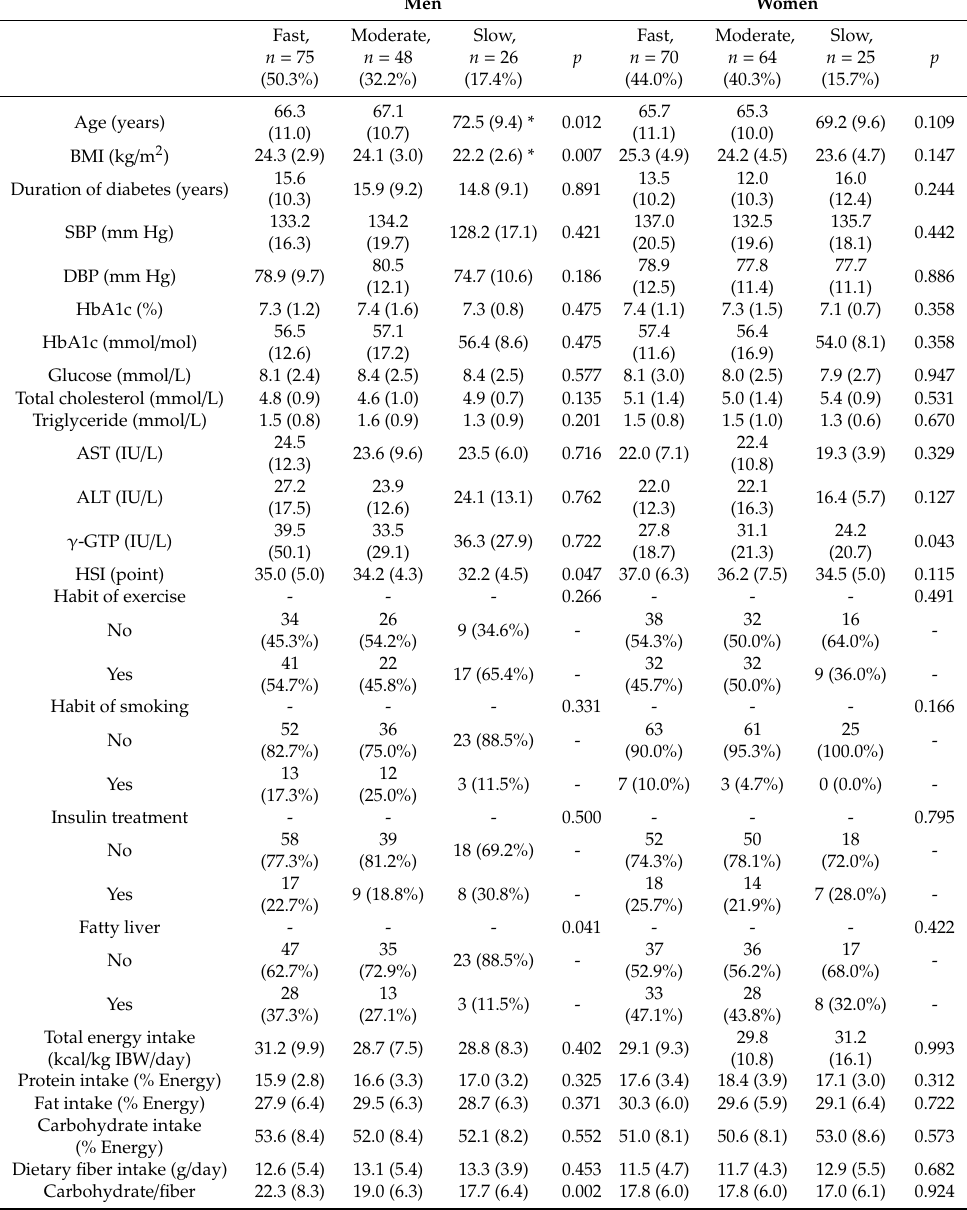
Table 2. The characteristics of the patients according to eating